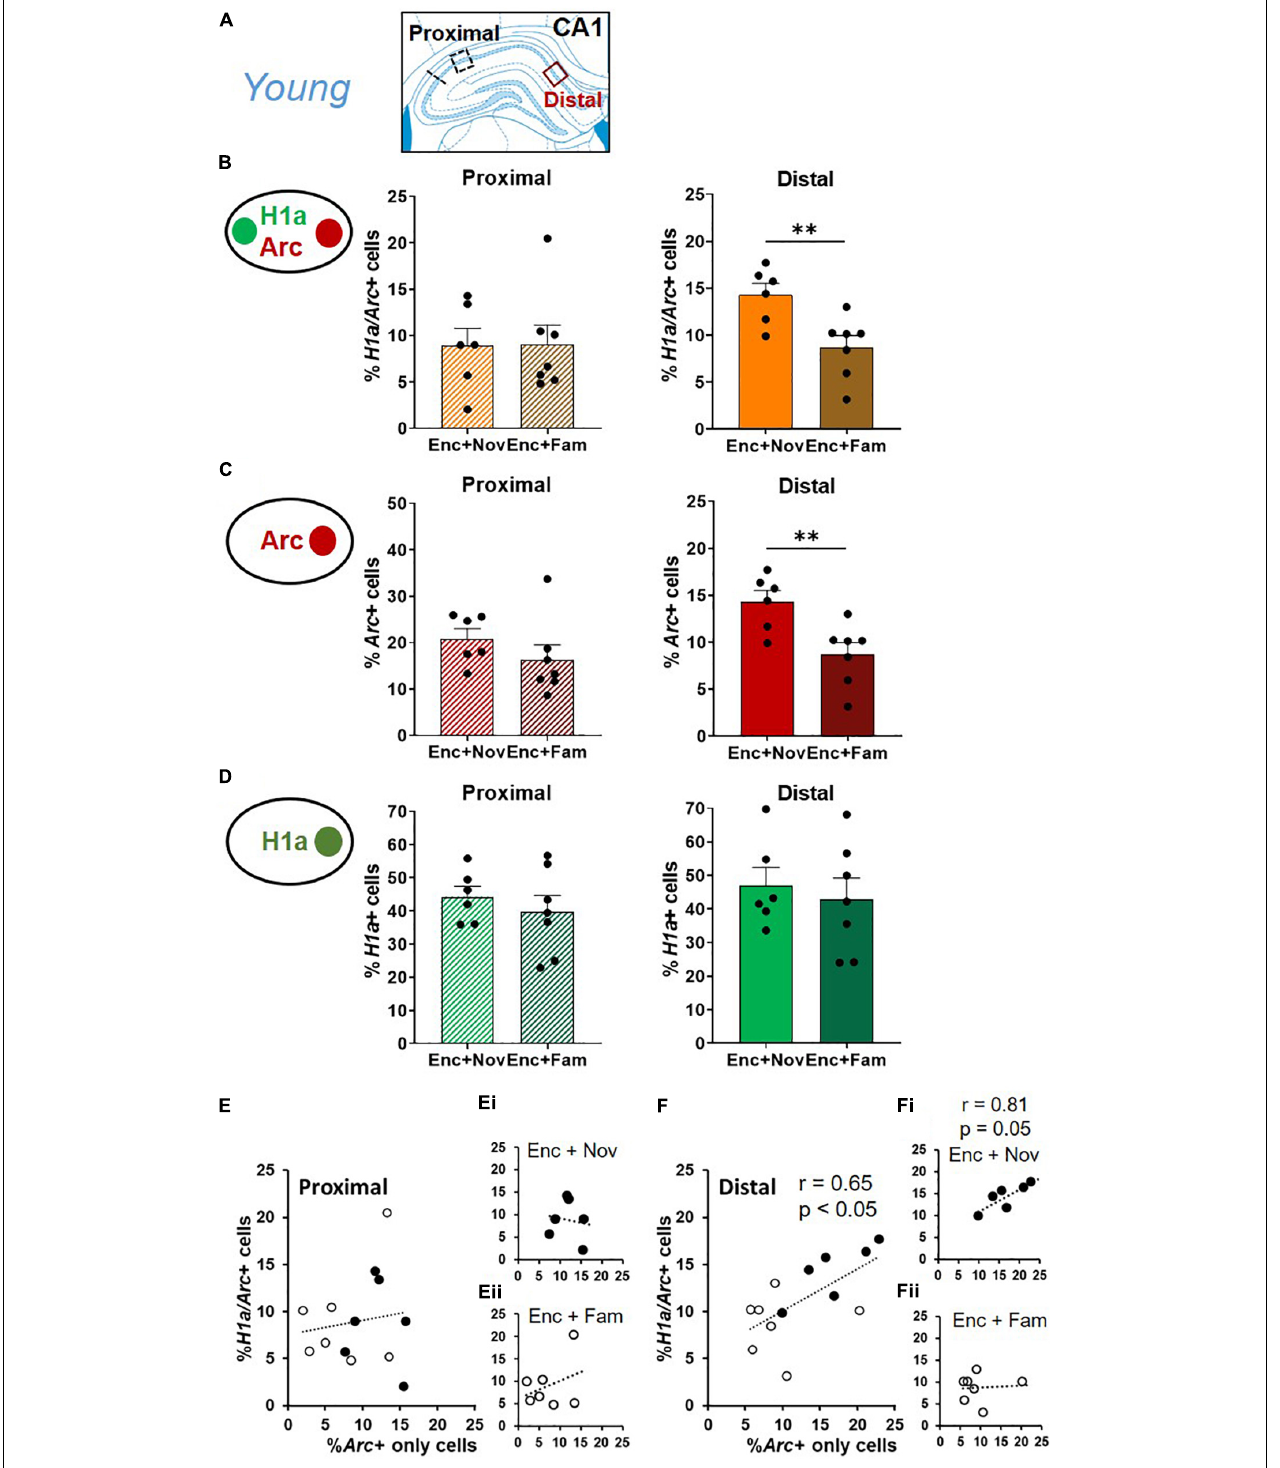
FIGURE 6 | Distal CA1 activation during behavioral tagging in young rats. (A) Areas of CA1 where images were taken and separated as proximal and distal CA1. (B) The percentage of H1a / Arc + neurons activated in the Enc + Nov group was higher in distal CA1. No difference was observed in proximal CA1. (C) The percentage of Arc + neurons activated by box exploration was higher with novelty (Nov) than with familiarity (Fam) in distal CA1. No difference was observed in proximal CA1. (D) The percentage of H1a + neurons activated by ADMP encoding was similar between Enc + Nov and Enc + Fam groups in proximal and